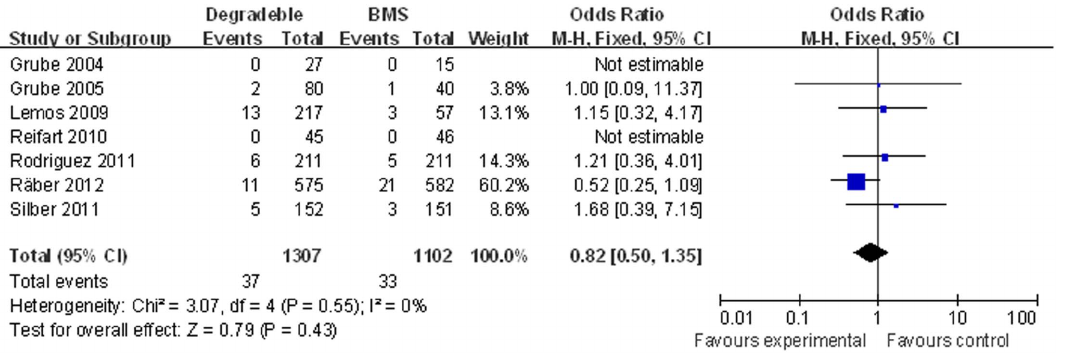
Figure 3. Individual and summary odds ratios for myocardial infarction in patients treated with BP-DES vs. BMS.